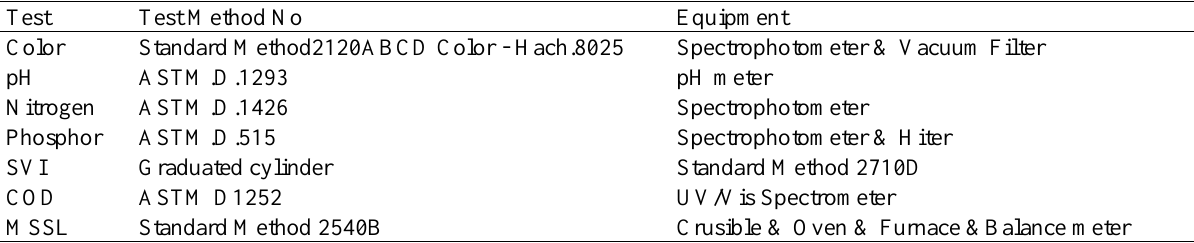
Table 3. Number of test methods and equipment used for experiment